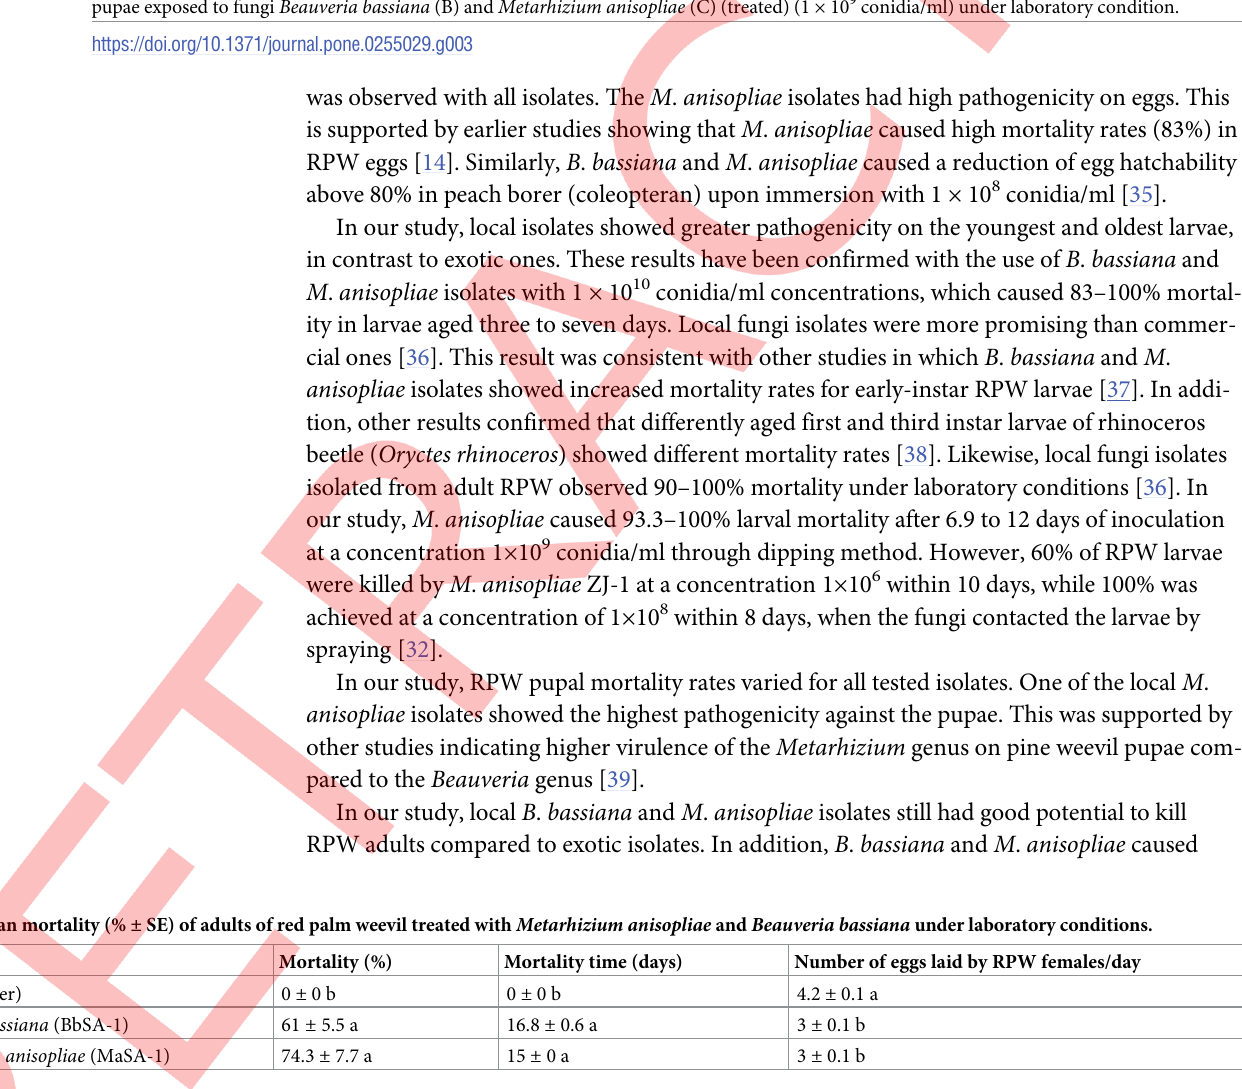
Fig 3. Comparison of healthy and fungi treated red palm weevil pupae. Healthy pupae exposed to distilled water (control) (A) and infected pupae exposed to fungi Beauveria bassiana (B) and Metarhizium anisopliae (C) (treated) (1 × 10 9 conidia/ml) under laboratory condition.